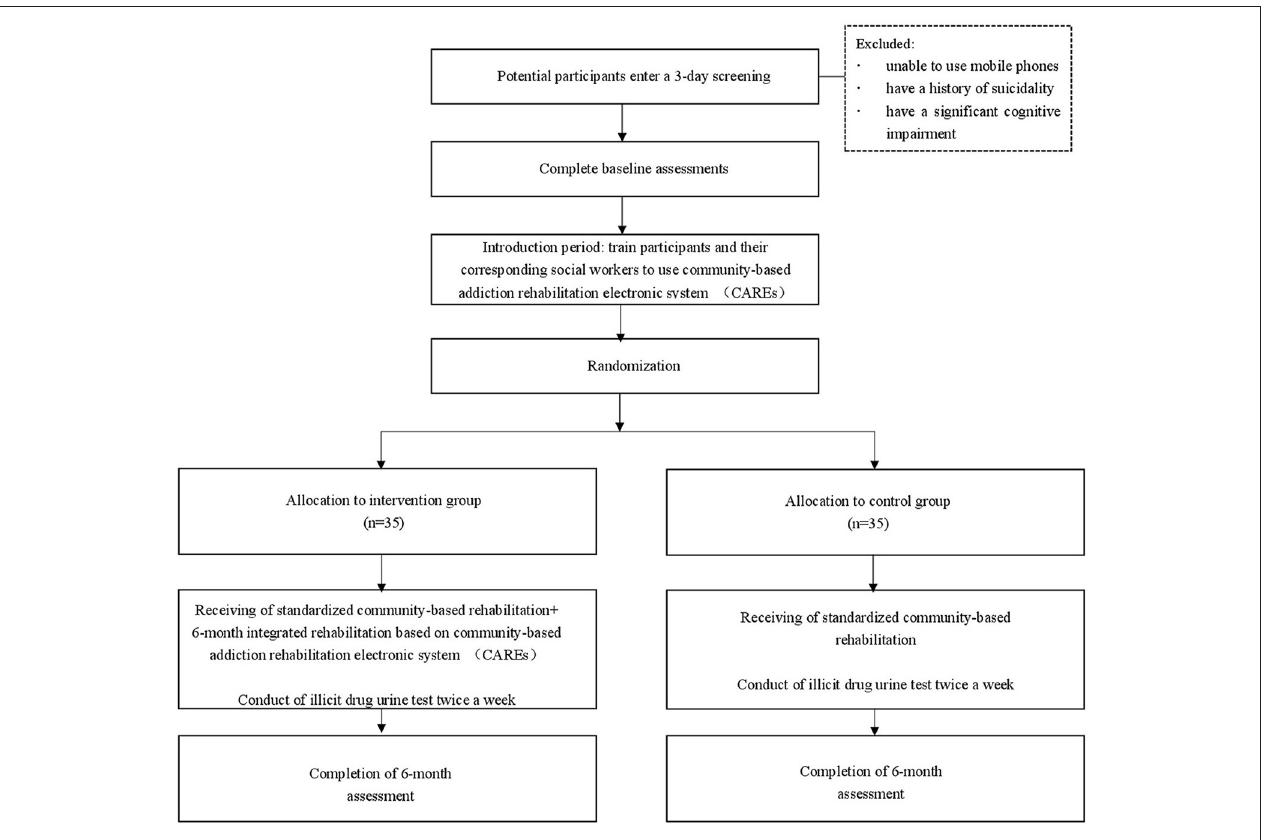
FIGURE 4 | Participant flow